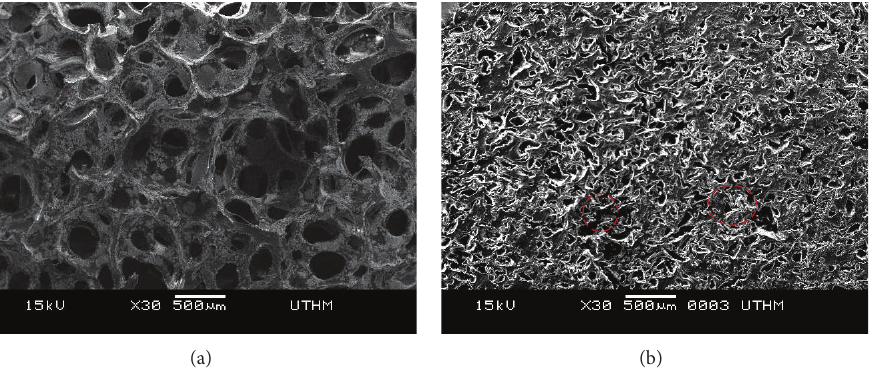
Figure 6: SEM micrograph: (a) BF samples (b) CB